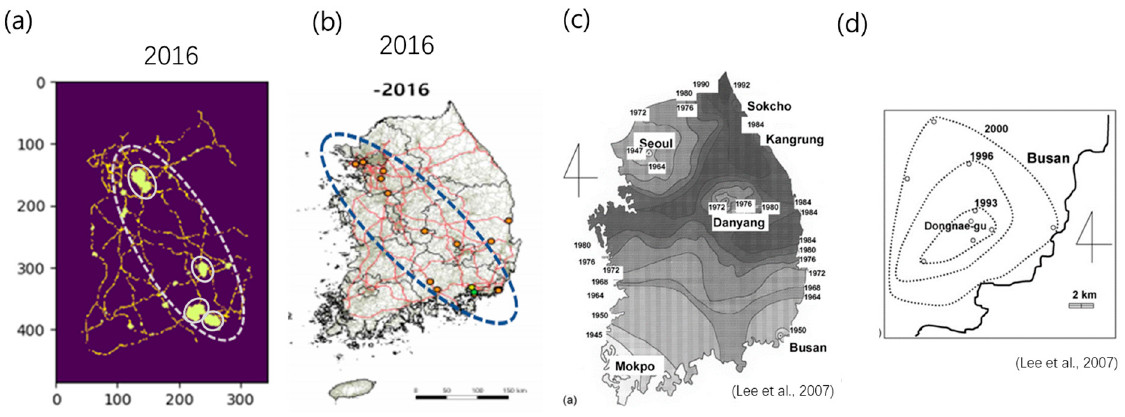
Figure 10. Simulation results for WCSB dispersal according to LSM plus SNM in 2016 (dotted ellipse indicating global, linear dispersal and solid ellipses presenting local, circular dispersal) ( a ), compared with field data (dotted ellipse indicating global, linear dispersal) ( b ), dispersal of Pine needle gall midge [15] ( c ), and dispersal of Pine wilt disease [15] ( d ). (The symbols resembling ‘4’ in ( c,d ) present orientation with the top indicating north.)